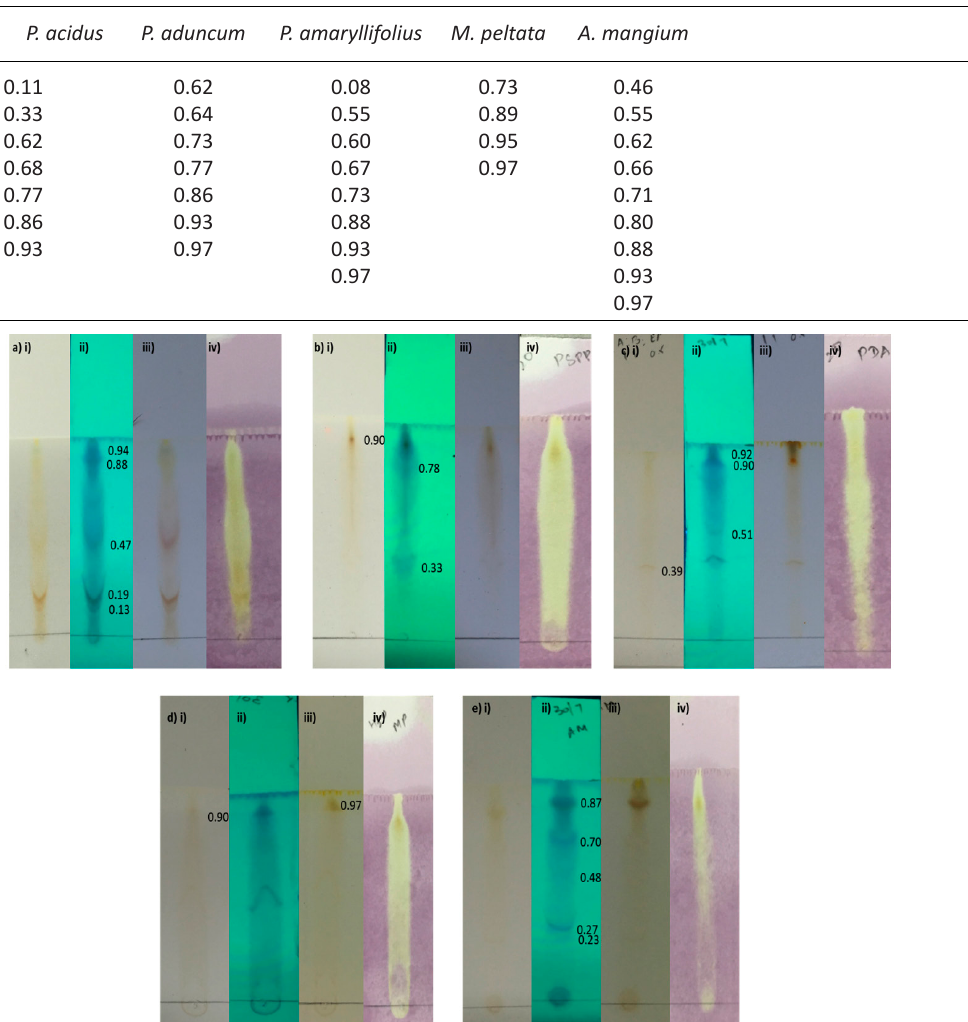
value of compounds separated from chloroform plant extracts Table 2. R f P. acidus